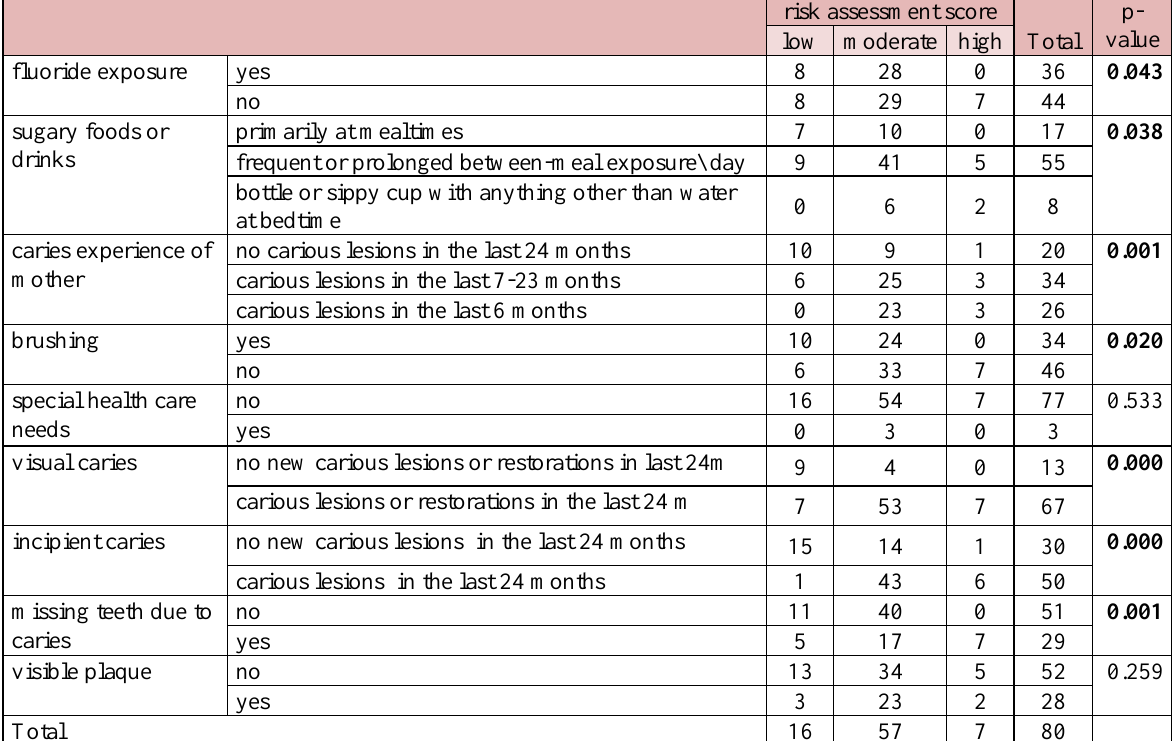
Figure 2: Distribution of the participants according to their risk assessment score. Table (3): Association between the risk assessment score and various